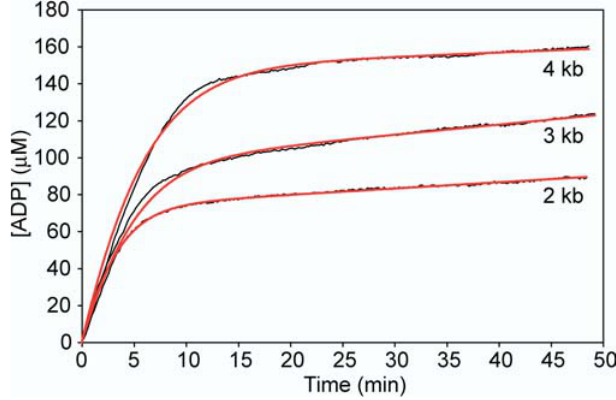
Figure 8. RecA Filament Disassembly Rates Are Independent of DNA Length Typical disassembly curves are shown for the 2-, 3-, and 4-kbp DNA substrates. The black lines are the data, and the orange lines represent the best fits to the data by equation 1. Note that the early, rapid phase of the curves are extended in concert with the increase in the length of the DNA substrates. The rates of disassembly derived from the curves are identical within experimental error, as summarized in Table 1 and the text. DOI: